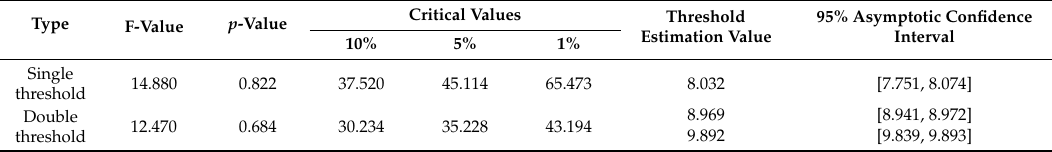
Table A6. The significance test results for energy consumption (EC) threshold e ff